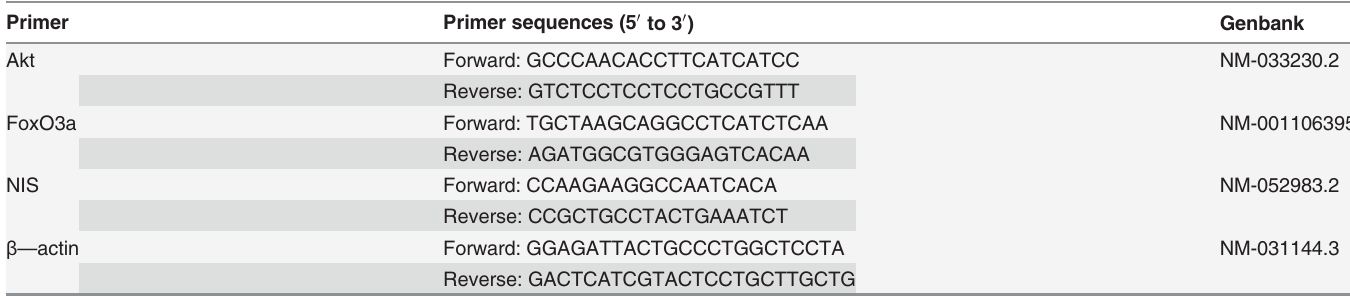
Table 1. Primers used for quantitative real-time PCR.